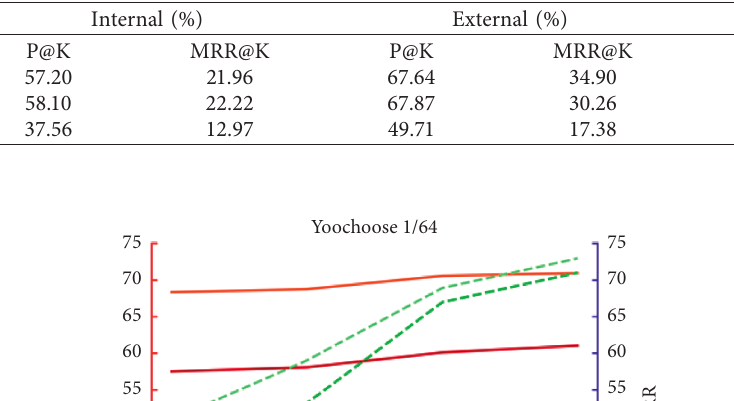
Figure 5: MRR@20 of different connection Table 4: The performance of diverse session embeddings ( K � 20).